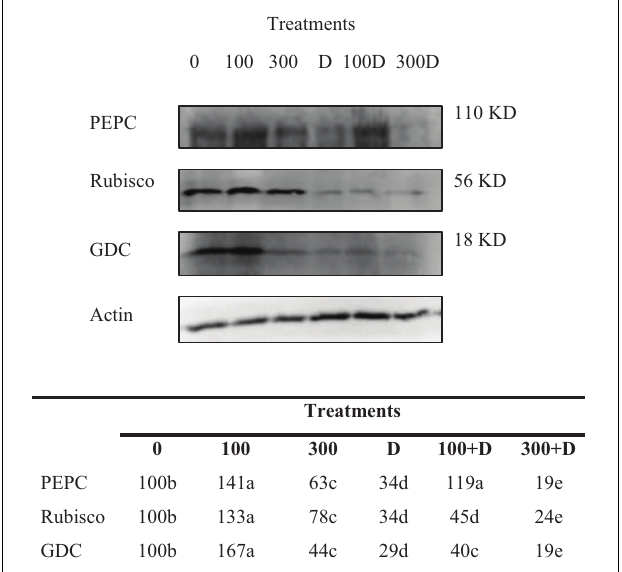
FIGURE 3 | Variations of photosynthetic protein expressions. Immunoblots of phosphoenolpyruvate carboxylase (PEPC), ribulose 1-5, bisphosphate carboxylase/oxygenase (Rubisco), and glycine decarboxylase (GDC) expressed changes in the protein expressions under treatments of 0, 100, and 300 mM NaCl, drought (D), and a combination of salinity with drought [100 and 300 mM NaCl + drought (100 + D and 300 + D respectively)]. Different letters denote, after Bonferroni post hoc test, significant difference ( P <